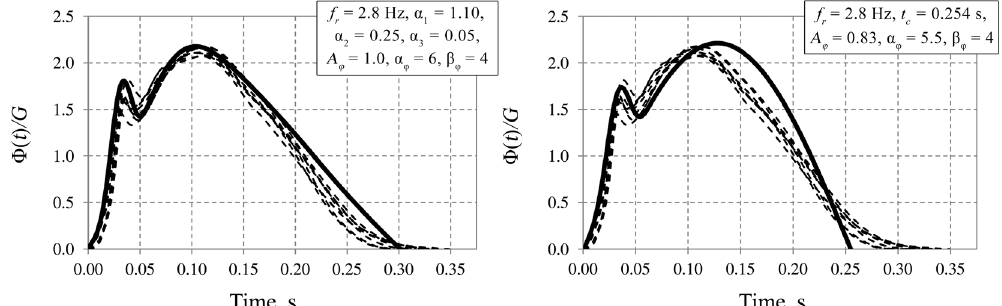
Figure 11. Illustration of the normalised